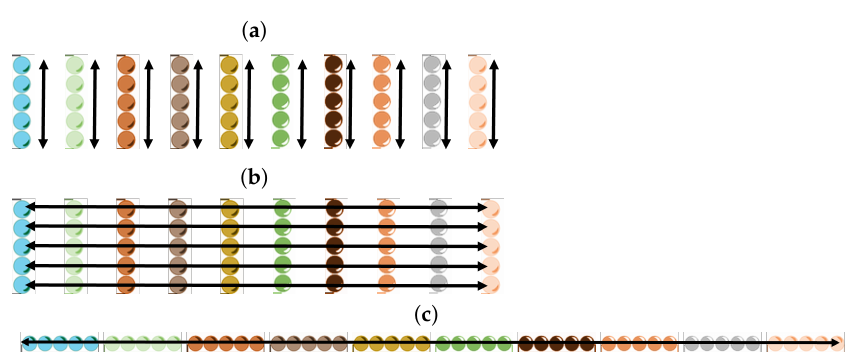
Figure 15. Three search strategies discussed in this paper. N = N A is the number of items considered in attention search—each labeled with a location and starting time—and each has a window of length W. W = 5 in the diagram. N A = N B = N loc here. ( a ) Temporal: At each location, look over time window O ( NW 2 ) . ( b ) Spatial: Look across items at fixed position in time window O ( N 2 W ) . ( c ) Full: Look over all space time windows in batch O ( N 2 W 2 )